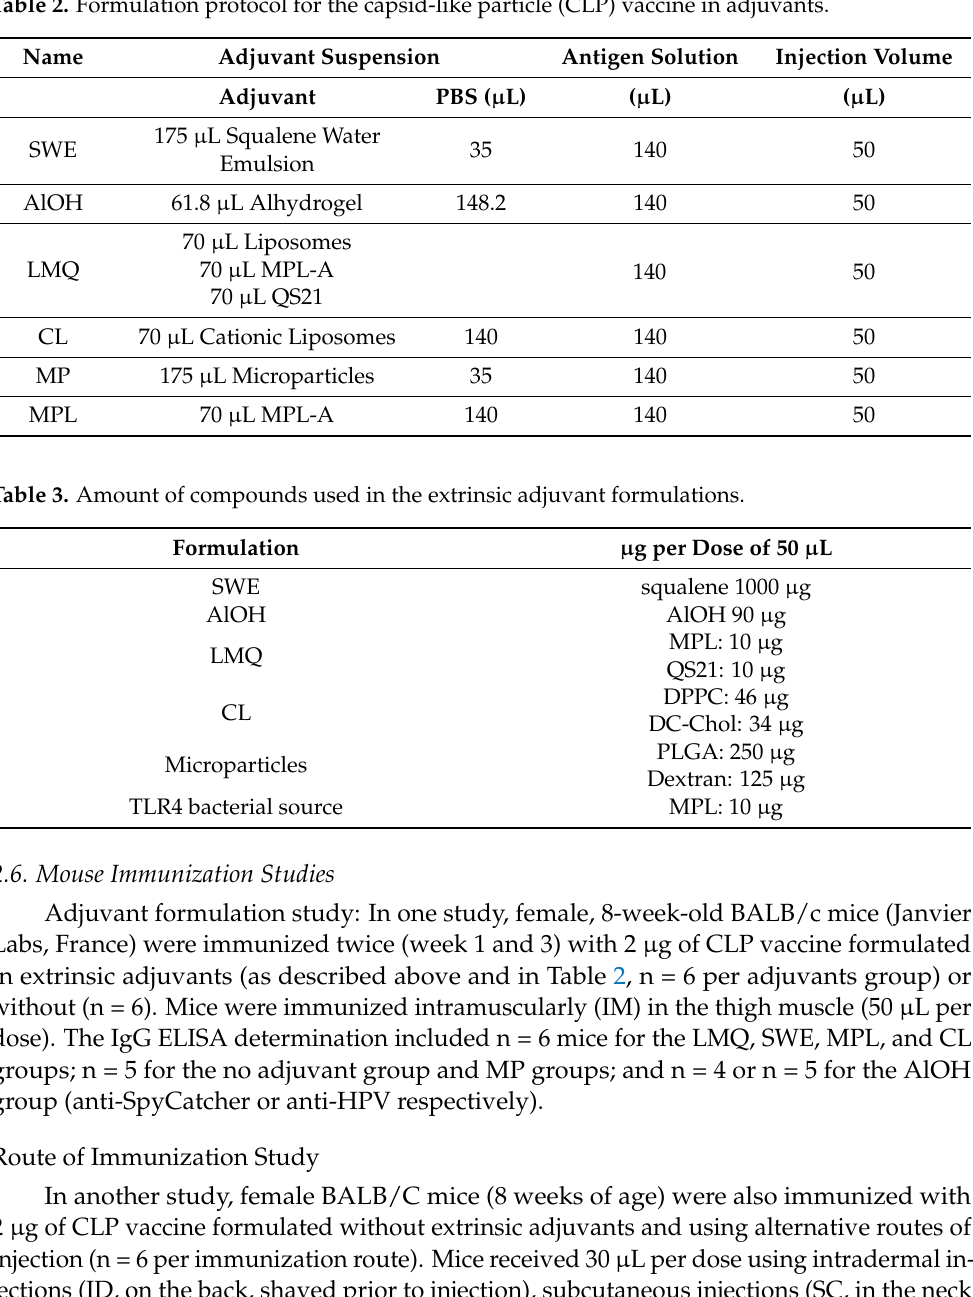
Table 2. Formulation protocol for the capsid-like particle (CLP) vaccine in adjuvants.